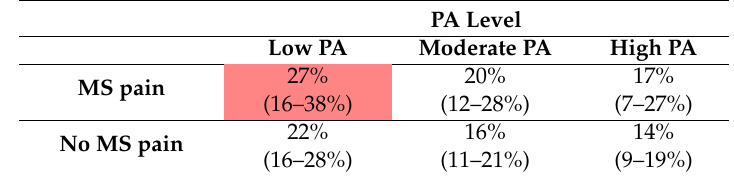
Table 4. Risk matrix model for boys. Probability of obesity (BMI ≥ 30 kg / m 2 ) (percentage, (95% CI)) in young